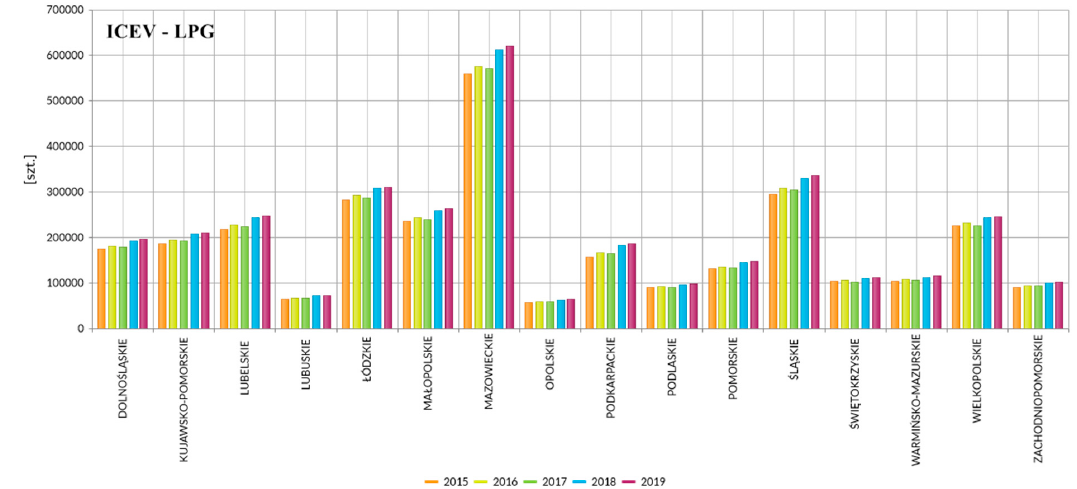
Figure 4. Number of ICEV LPG fueled vehicles.